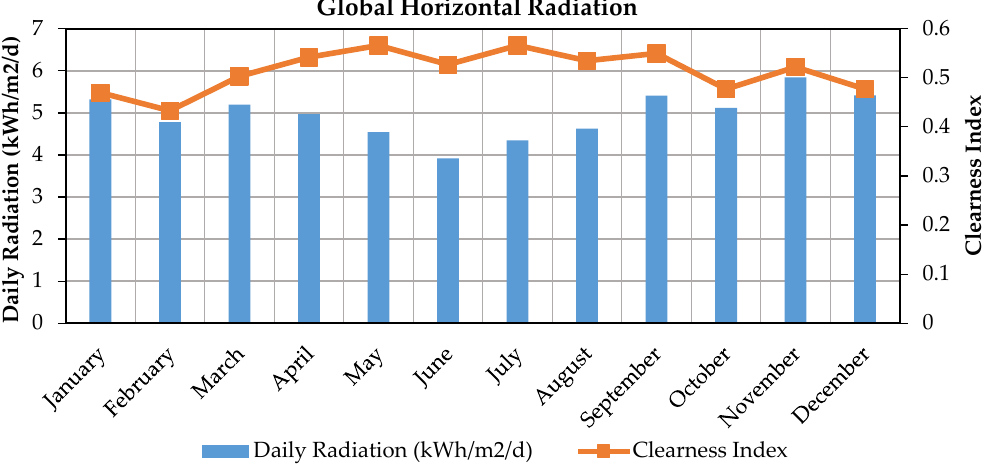
Figure 2. Global horizontal solar radiation, Tacuaral de Mattos, Bolivia.